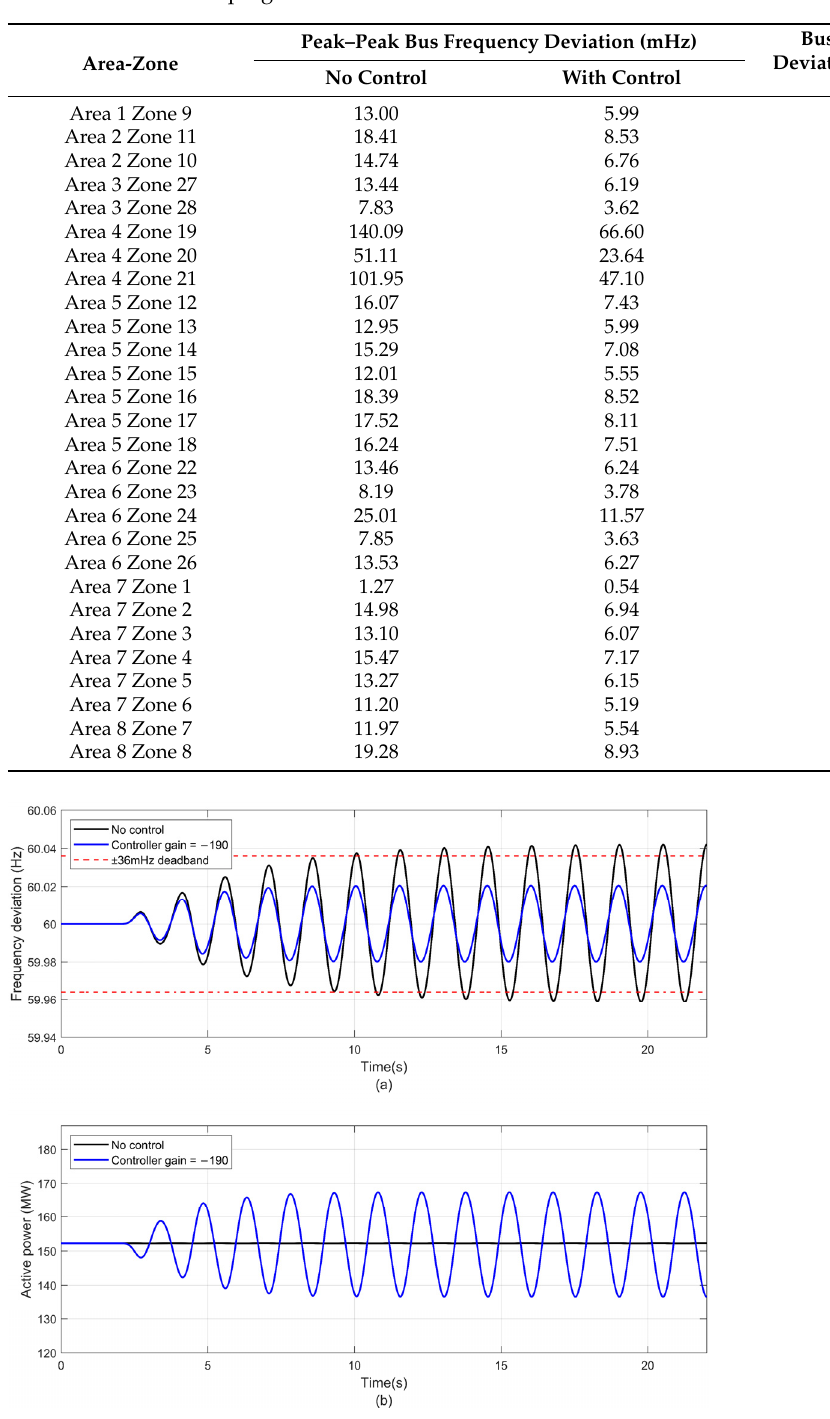
Figure 9. ( a )Area 4 Zone 19 frequency deviation improvement. ( b ) Active power output of the actuator at Area4 Zone 19 when the forced source at Area 4 Zone 20.